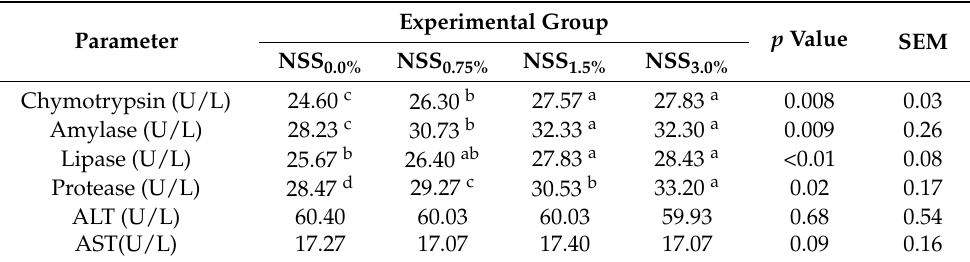
Table 4. Digestive and liver enzymes of Nile tilapia ( O. niloticus ) fed diets enriched with different levels of a microalgae mix (NSS) containing Nannochloropsis oculate and Schizochytrium and Spirulina species at equal proportions (1:1:1) for 12